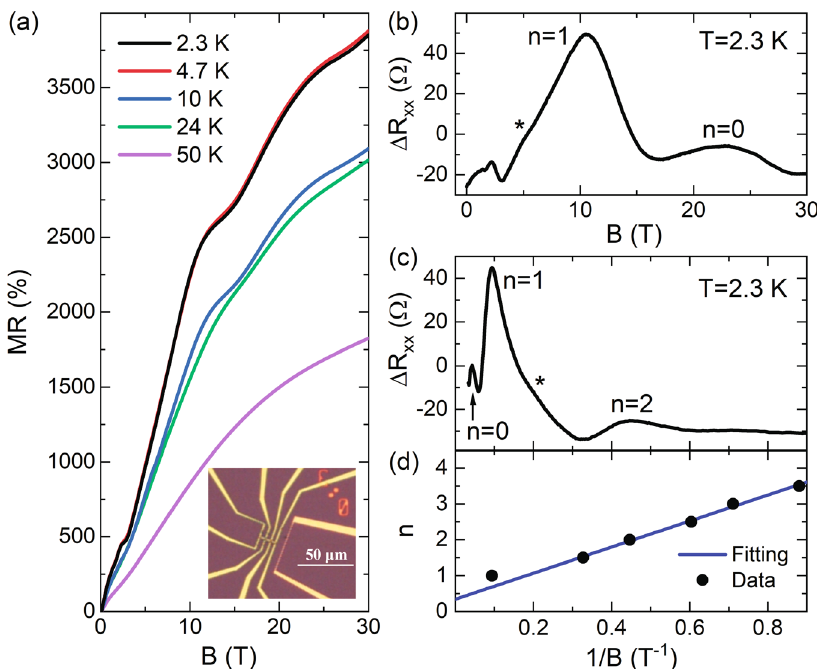
Fig. 2 Magneto-resistance measurements in ZrTe 5 . a Magneto-resistance, MR ≡ [ R xx ( B )/ R xx (0T) − 1] × 100%, measured at different temperatures. Inset: Optical microscope image of a device designed for both MR and magneto-thermopower measurements. b Quantum oscillations in Δ R xx as a function of B at 2.3 K. c Δ R xx as a function of 1/ B at 2.3 K. Δ R xx is obtained by subtracting a smooth background (we choose R xx (50 K) as the background) from R xx , Δ R = R − R ⋆ symbol indicates a possible splitting of the n = 1 peak. d Landau fan diagram of the SdHOs, with the peaks (valleys) in xx xx (2.3 K) xx (50 K). The Δ R n ( n + 1/2), respectively. The straight line is a linear fi t to the data at n > xx assigned to